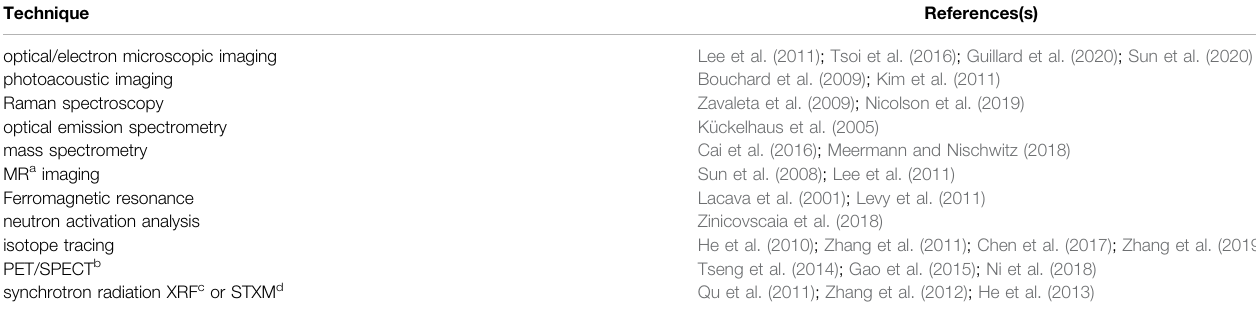
TABLE 1 | Techniques for NMs quanti fi cation or imaging.